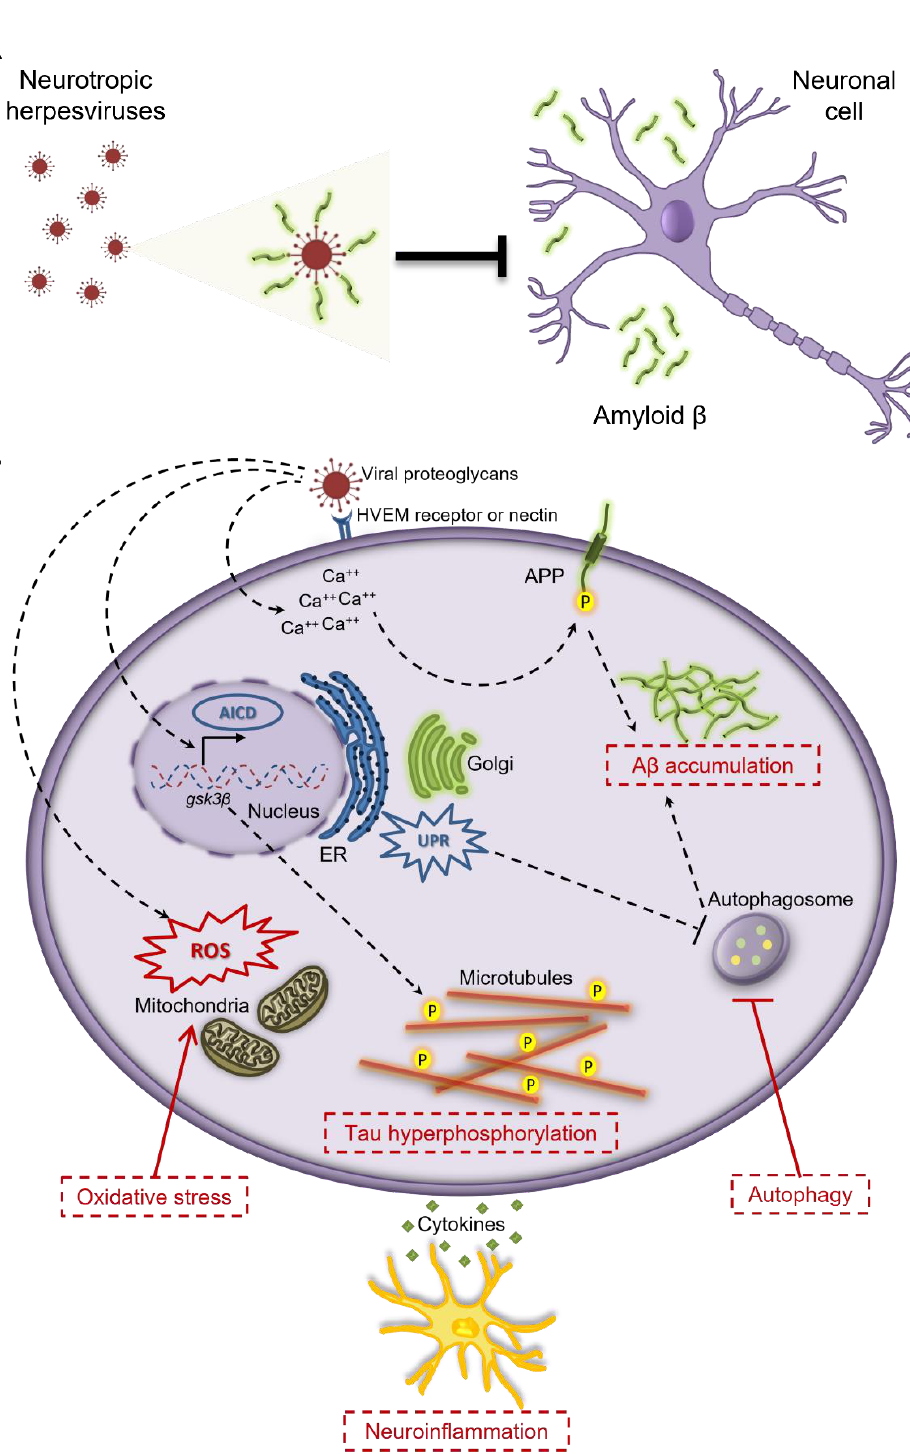
Figure 1. Neurotropic human herpesviruses drive the generation of AD hallmarks directly via interactions with the viral surface ( A ), or indirectly by affecting different molecular mechanisms ( B ), such as mechanisms involved in A β deposition, tau protein hyperphosphorylation, autophagy, oxidative stress, and neuroinflammation. HVEM: Herpesvirus Entry Mediator, AICD: APP Intracellular Domain, gsk3 β : glycogen synthase kinase 3 β , UPR: Unfolded Protein Response, APP: Amyloid Precursor Protein, A β : Amyloid β , ER: Endoplasmic Reticulum, ROS: Reactive Oxygen Species.